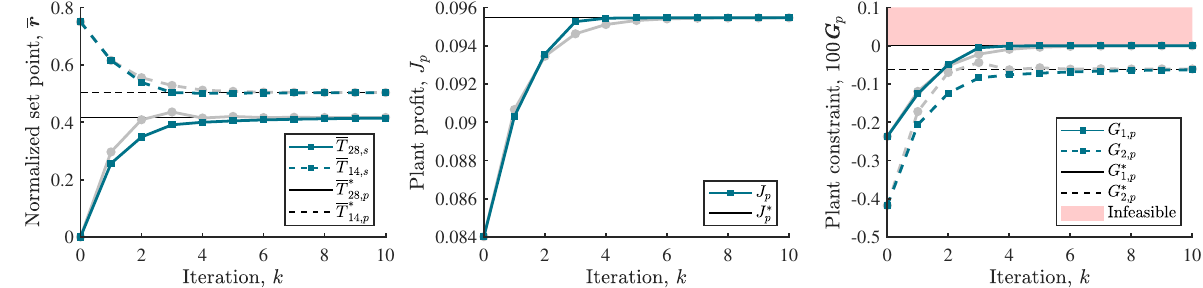
Figure 10. Distillation column RTO trajectory for MSMA using the mean solution approach shown as the blue square line. Stable solution for standard MA is shown for comparison as the grey circle line.